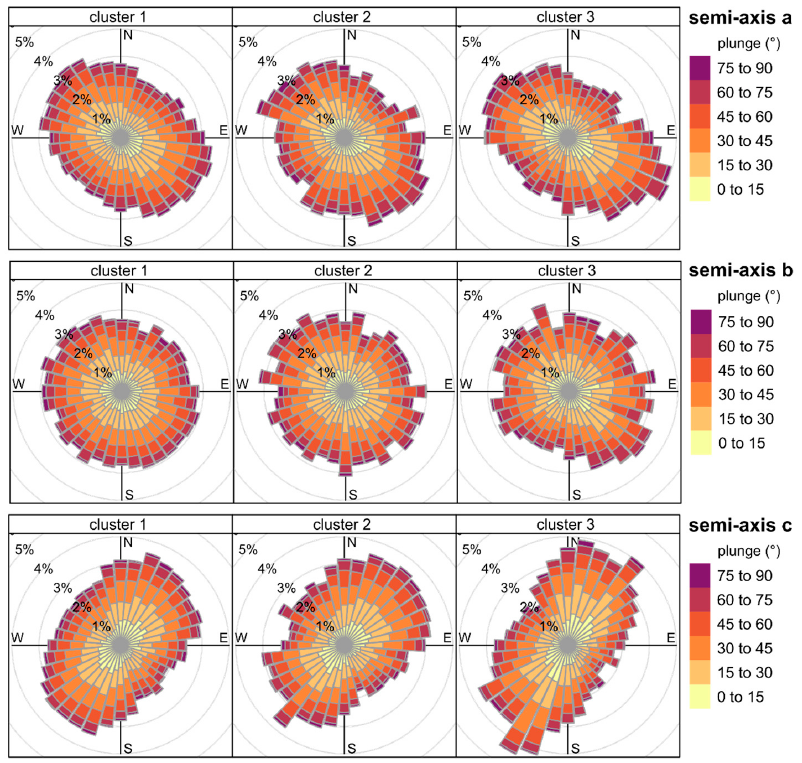
Figure 12. Spatial orientation of the grains in the clusters. The width of a bin is 10°; N equals 0°.